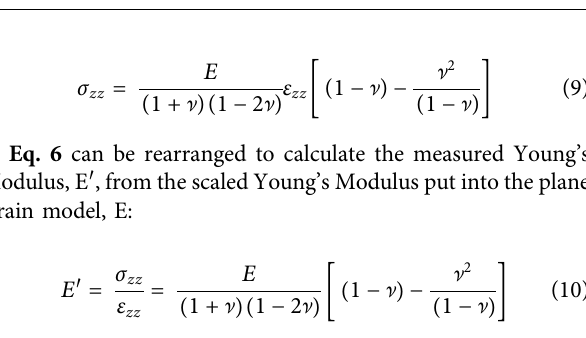
FIGURE 3 | (A) Effective elastic modulus from Yang et al. (2009) experiments with varied arrangements of pre-cut fractures plotted against the effective elastic modulusproducedinnumericalsimulationswiththesamepre-cutfacturecon fi gurations. Grayshaded regionshows ± 3 GParange. (B) Pre-cutfracturecon fi gurations from Yang et al. (2009) experiments used for